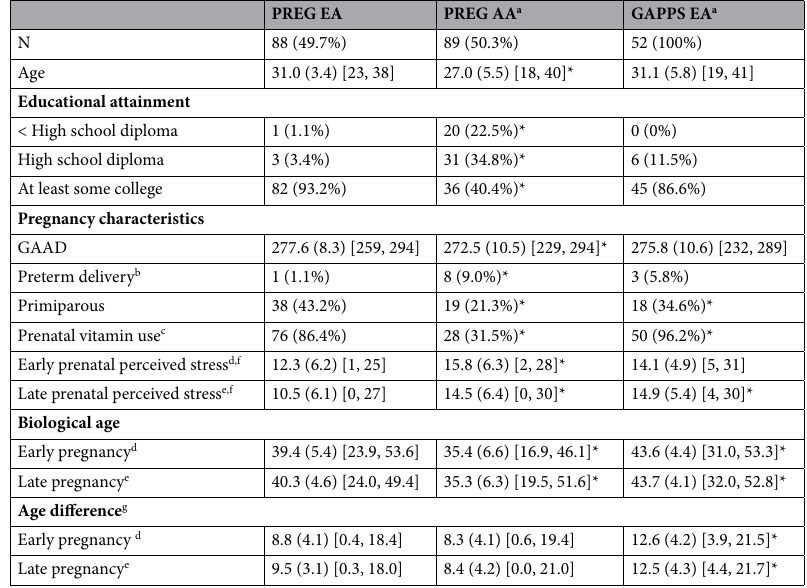
Table 1. Cohort characteristics. M (SD) [min, max] or N (%). EA = European American, AA = African American, GAAD = gestational age at delivery (in days). * p < 0.05 ; Welch’s t-test. a All comparisons tested against the PREG EA-only subset. b Delivery before 260 days gestation. c Only assessed at first study visit. d Corresponds to late first or second trimester. e Corresponds to third trimester. f Assessed using the Perceived Stress Scale 55 . g Absolute difference between maternal chronological age and biological age.